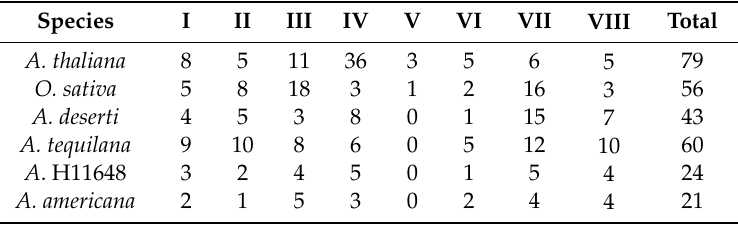
Table 2. Numbers of rice and Agave SAUR genes in groups I-VII.